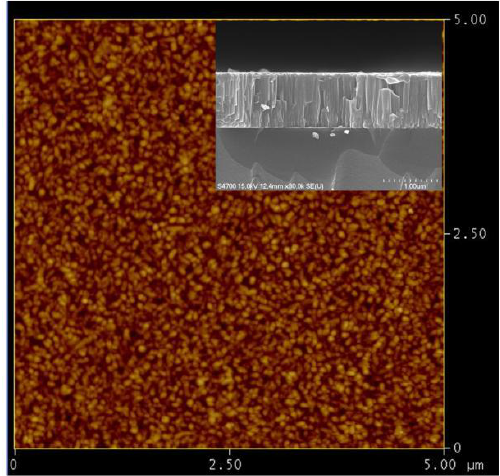
Figure 2. Atomic force microscopy (AFM) image of Cu growth temperature of 350 °C. The inset figure shows the corresponding cross-sectional scanning electron microscopy (SEM)